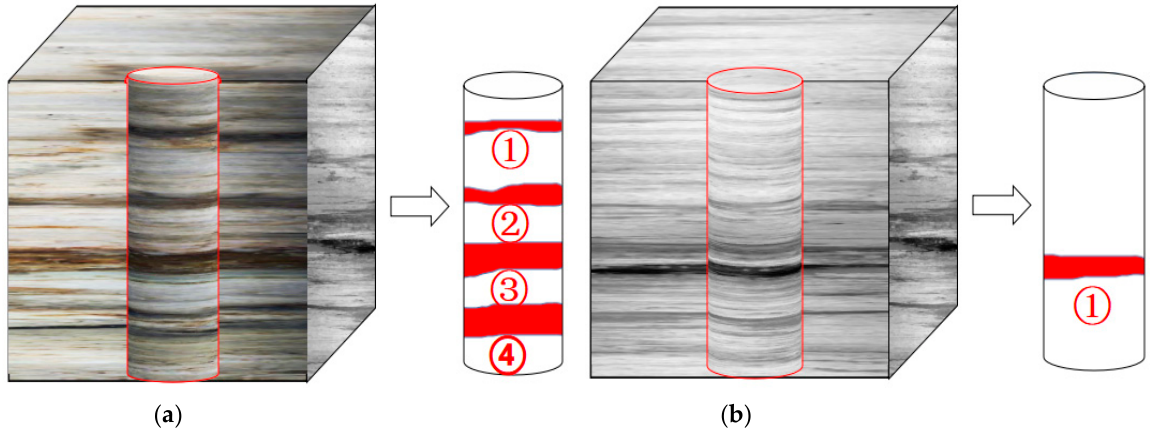
Figure 18. 3D formation images. ( a ) Formation image before fusion, ( b ) formation image after fu- sion.